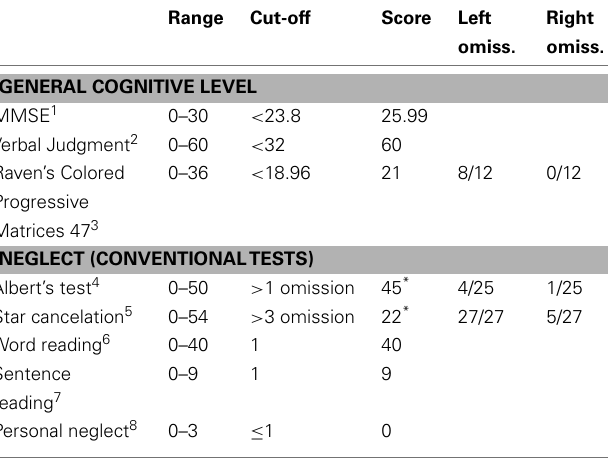
Table 1 | General neuropsychological assessment.